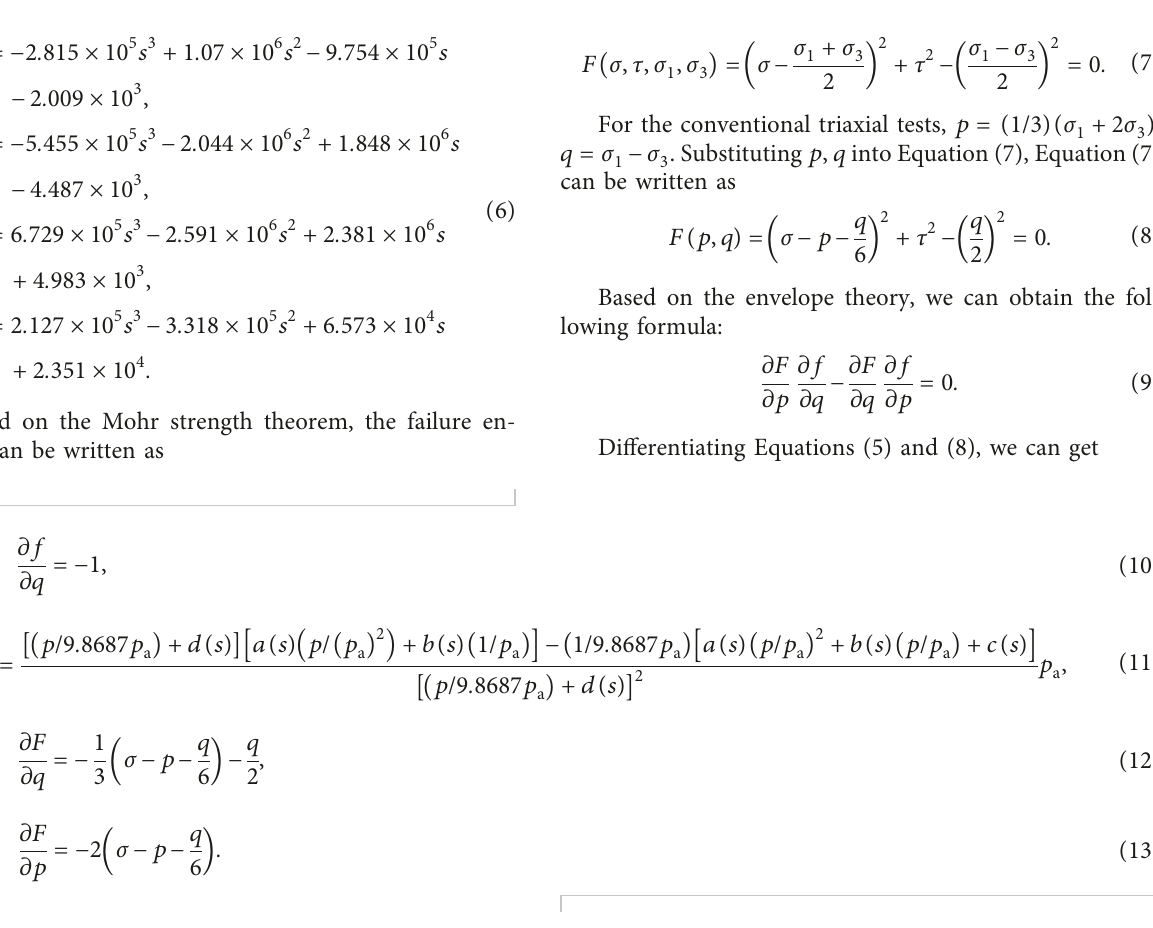
Figure 3: Test values and fitting curves of CSL with different salt